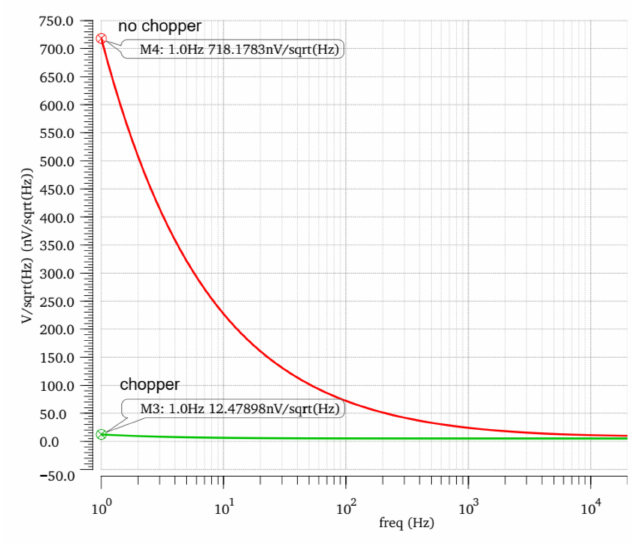
Figure 7. Noise simulation of chopper operational